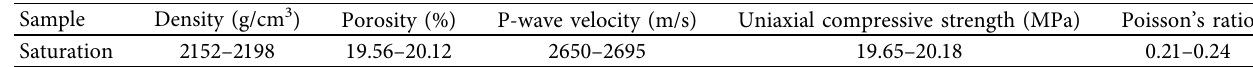
Figure 1: Fractured sandstone samples. (a) Sandstone specimens containing single fissure. (b) Sandstone specimens after Table 1: Basic physical and mechanical parameters of the sandstone used.